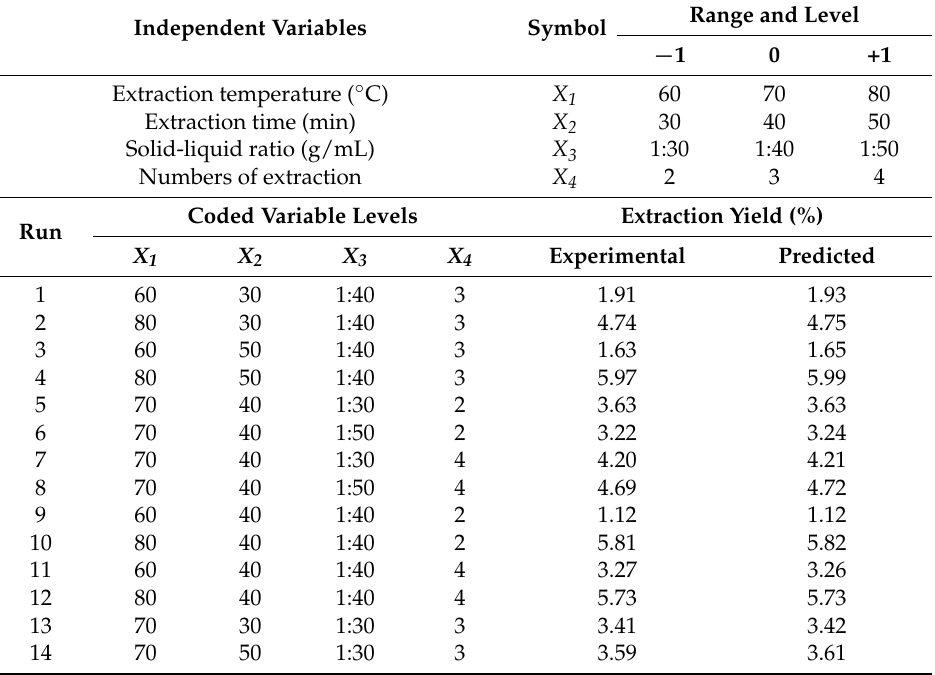
Table 1. Experimental design with predicted and experimental extraction yield of